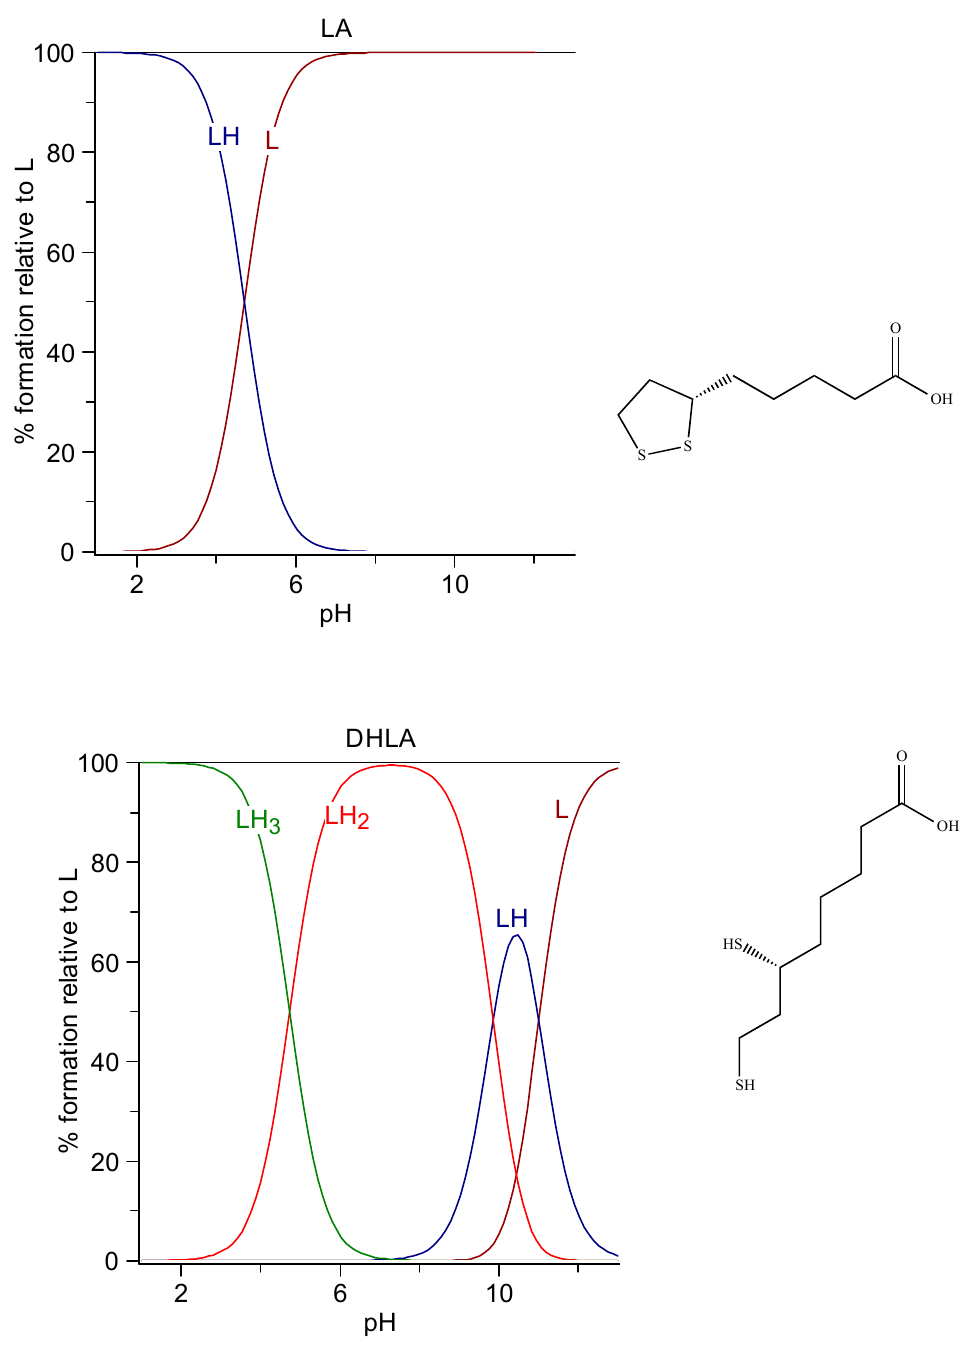
Figure 7. Speciation plots of Lipoic acid (top) and dihydrolipoic acid (DHLA) (bottom).